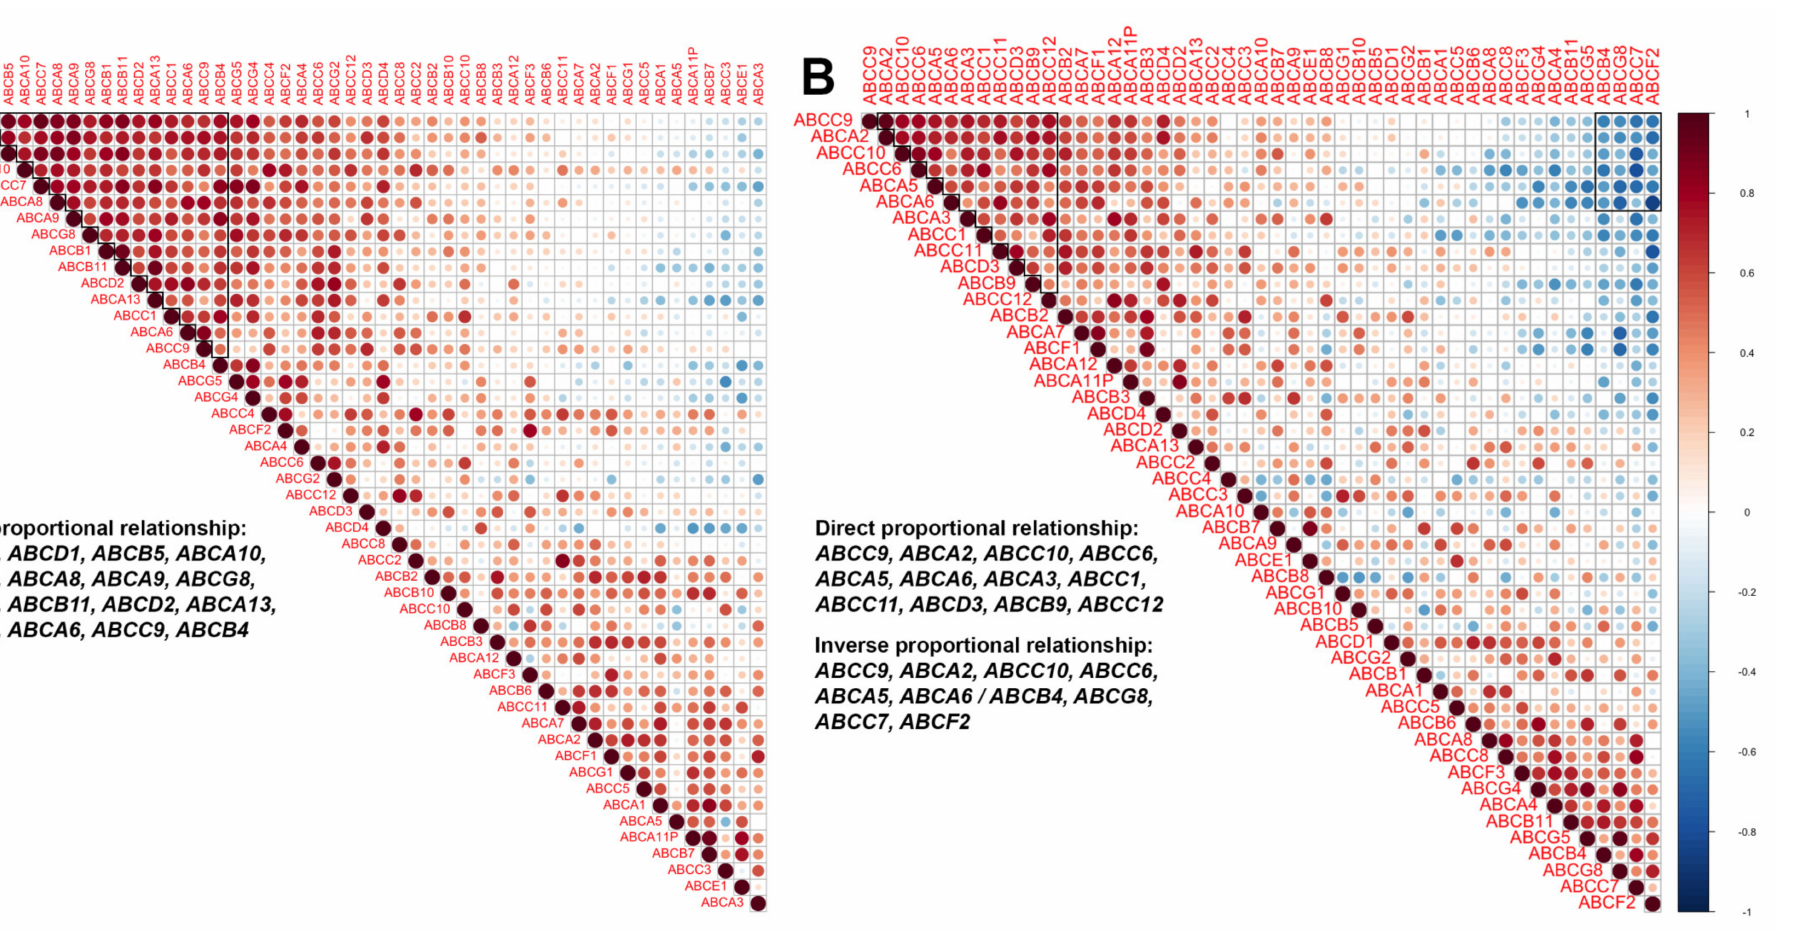
Figure 5. Correlation matrix of ABC transporter gene expression before ( A ) and after ( B ) treatment in patients without response. Note: groups of coexpression genes marked with black line (Spearmen coefficient, r > 0.5 or rs < − 0.5, p ≤